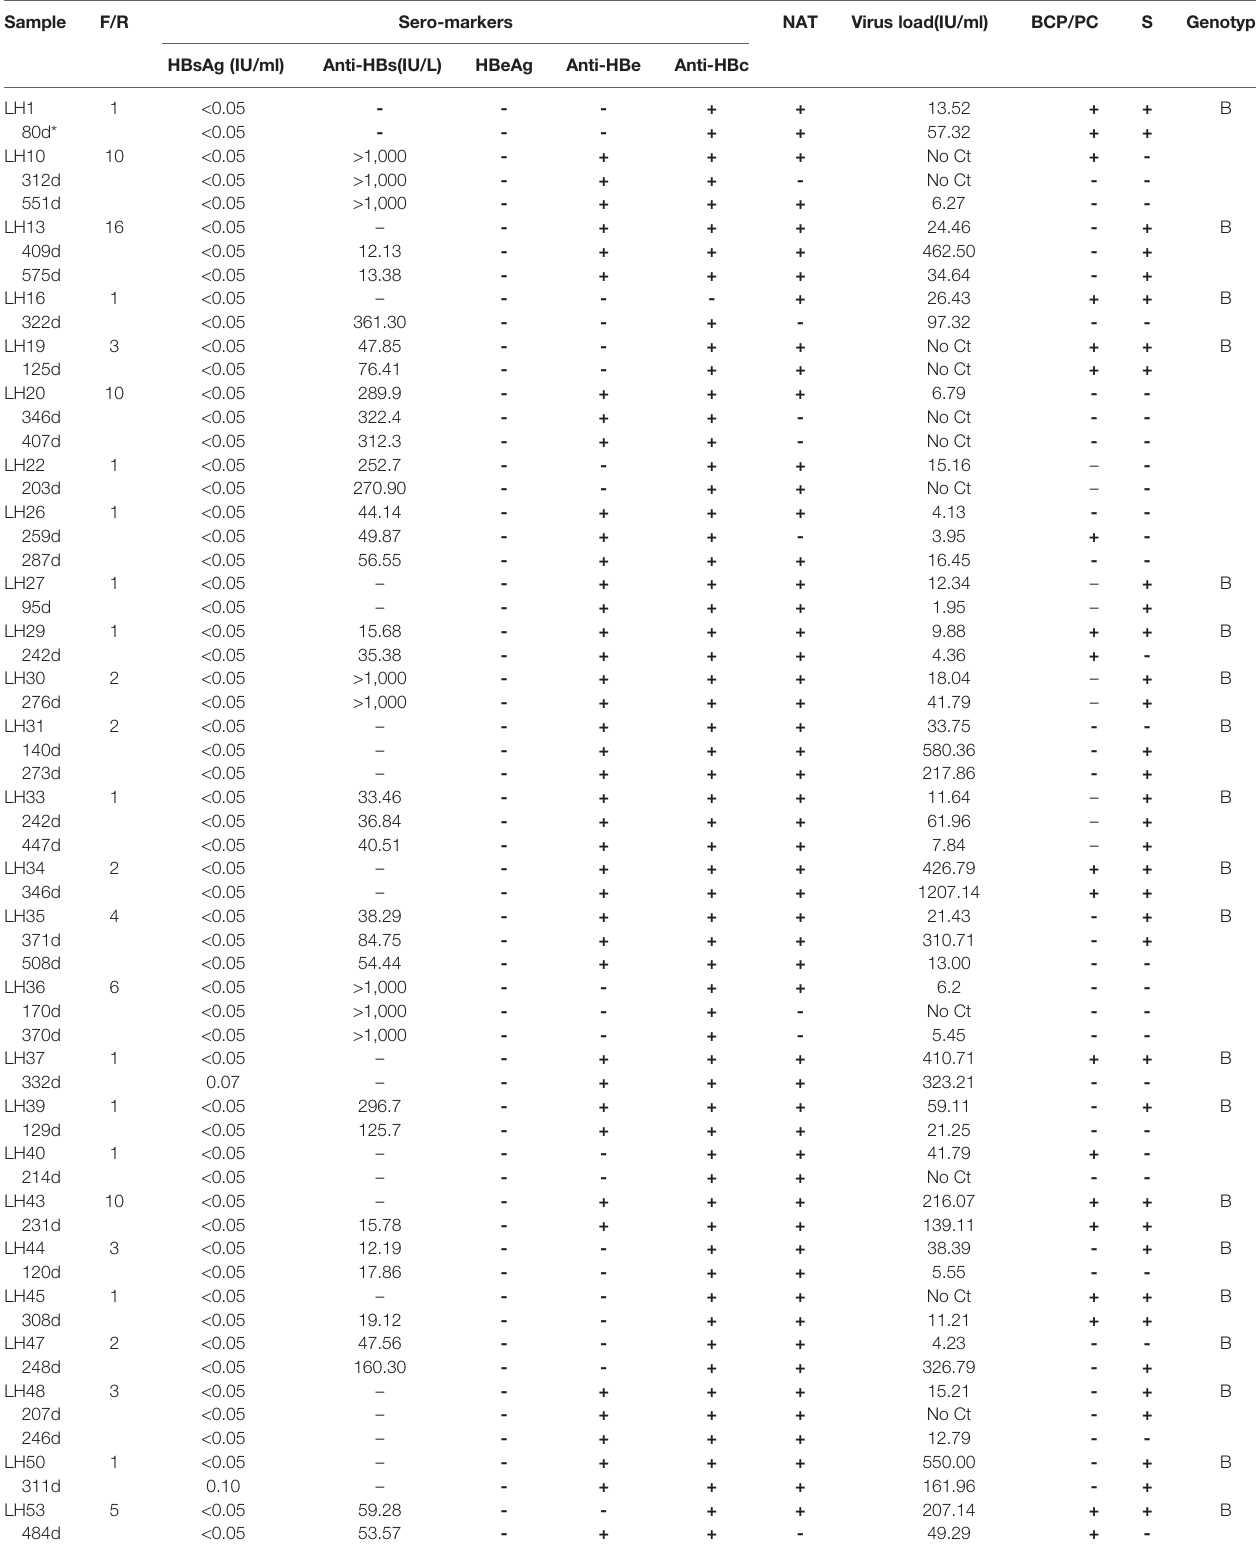
TABLE 3 | Follow-up analysis of 31 OBIs and 1 WP donors.